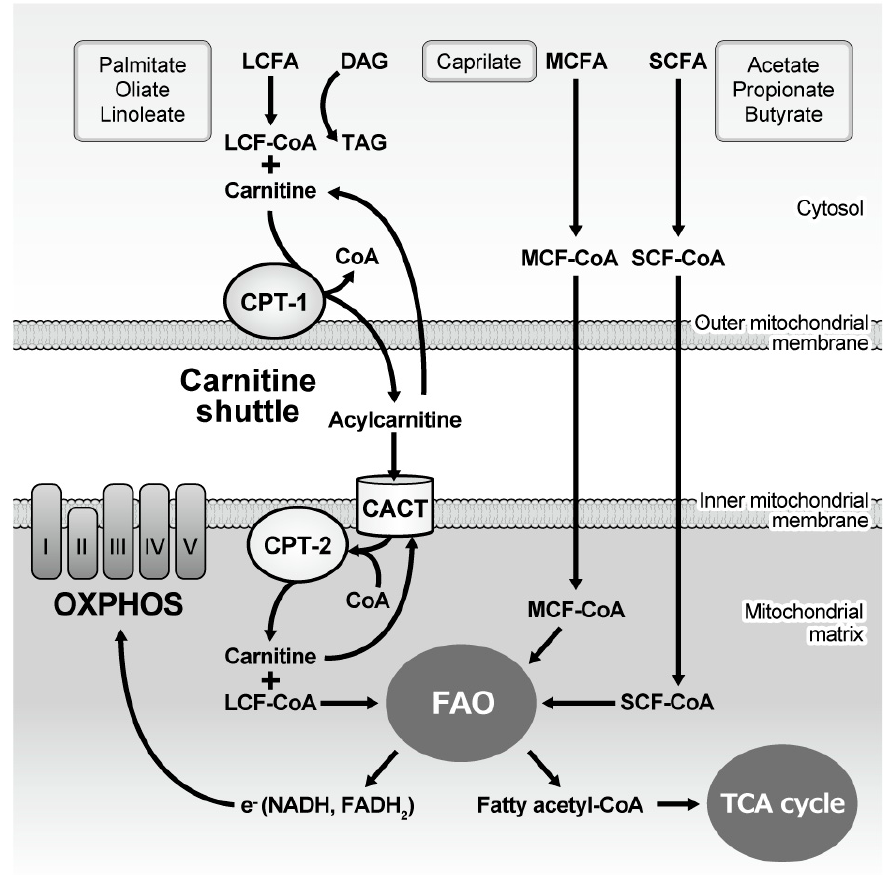
Figure 1. Mitochondrial handling of fatty acids and subsequent energy generation. Long-chain fatty acyl-CoA is esterified with carnitine in the cytoplasm and then the carnitine shuttle serves to carry it from the cytosol to the mitochondria, while medium- and short-chain fatty acyl-CoA freely diffuses into the mitochondria. Once the fatty acid is located inside the mitochondrial matrix, two carbons are cleaved from the molecule every cycle to form fatty acetyl-CoA, the process of which is named fatty acid oxidation ( β oxidation). The process continues until all of the carbons in the fatty acid are turned into acetyl CoA, which enters the TCA cycle to generate ATP. Oxidation also generates NADH and FADH 2 , electrons derived from which are utilized by the five OXPHOS complexes to generate ATP.